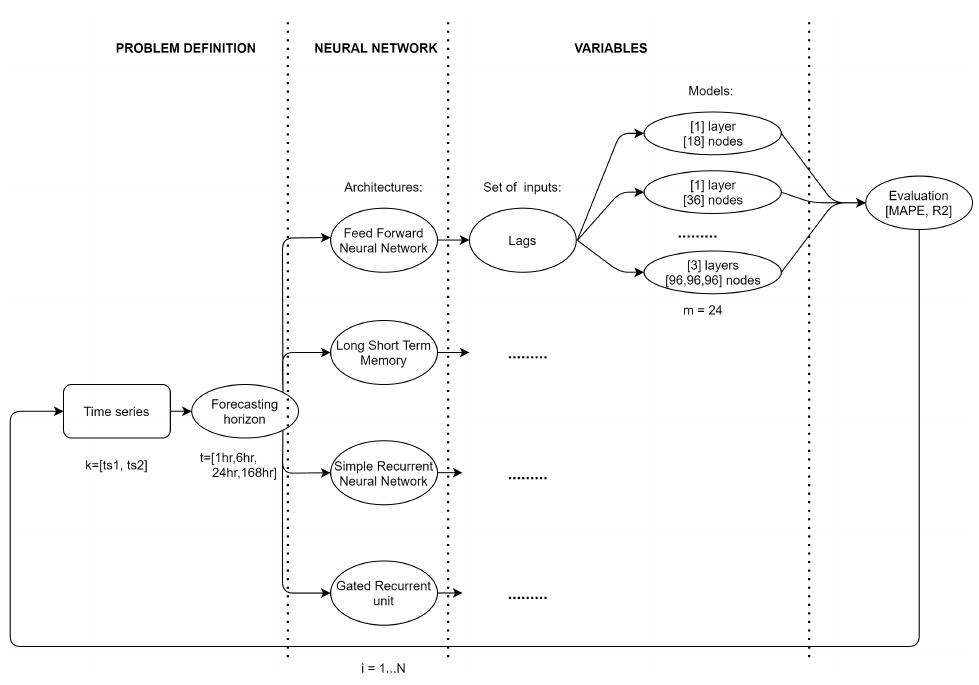
Figure 3. Flowchart of the proposed procedure for the analysis of ANN nodes and layers tuning based on an iterative grid search suitable for water demand prediction.